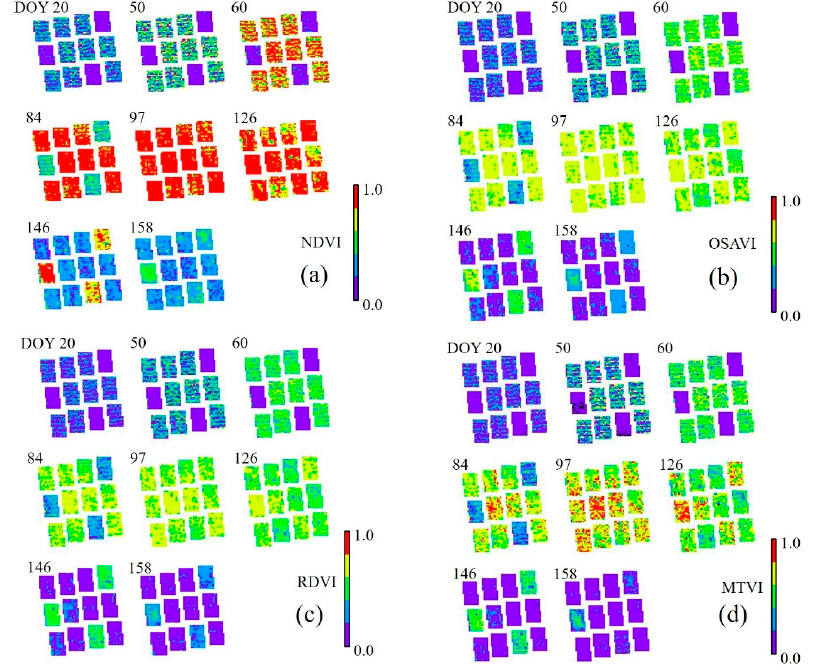
Figure A5. Variations in observed wheat vegetation indices at the Gyeongsang National University field in 2021. NDVI, normalised difference vegetation index ( a ), OSAVI, optimised soil-adjusted vegetation index ( b ), RDVI, re-normalised difference vegetation index ( c ), and MTVI, modified triangular vegetation index ( d ).